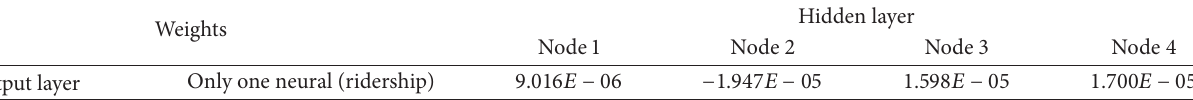
Table 4: Weights for nodes in output layer and hidden layer.